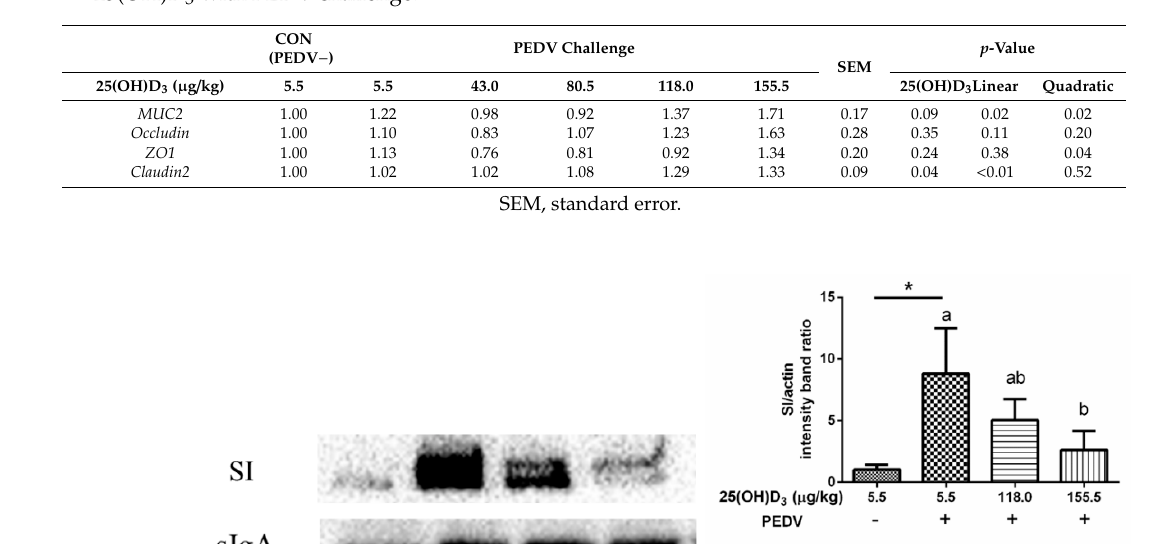
Table 6. Relative gene expression of intestinal barrier-related genes of weaned piglets fed the indicated 25(OH)D 3 with PEDV challenge.